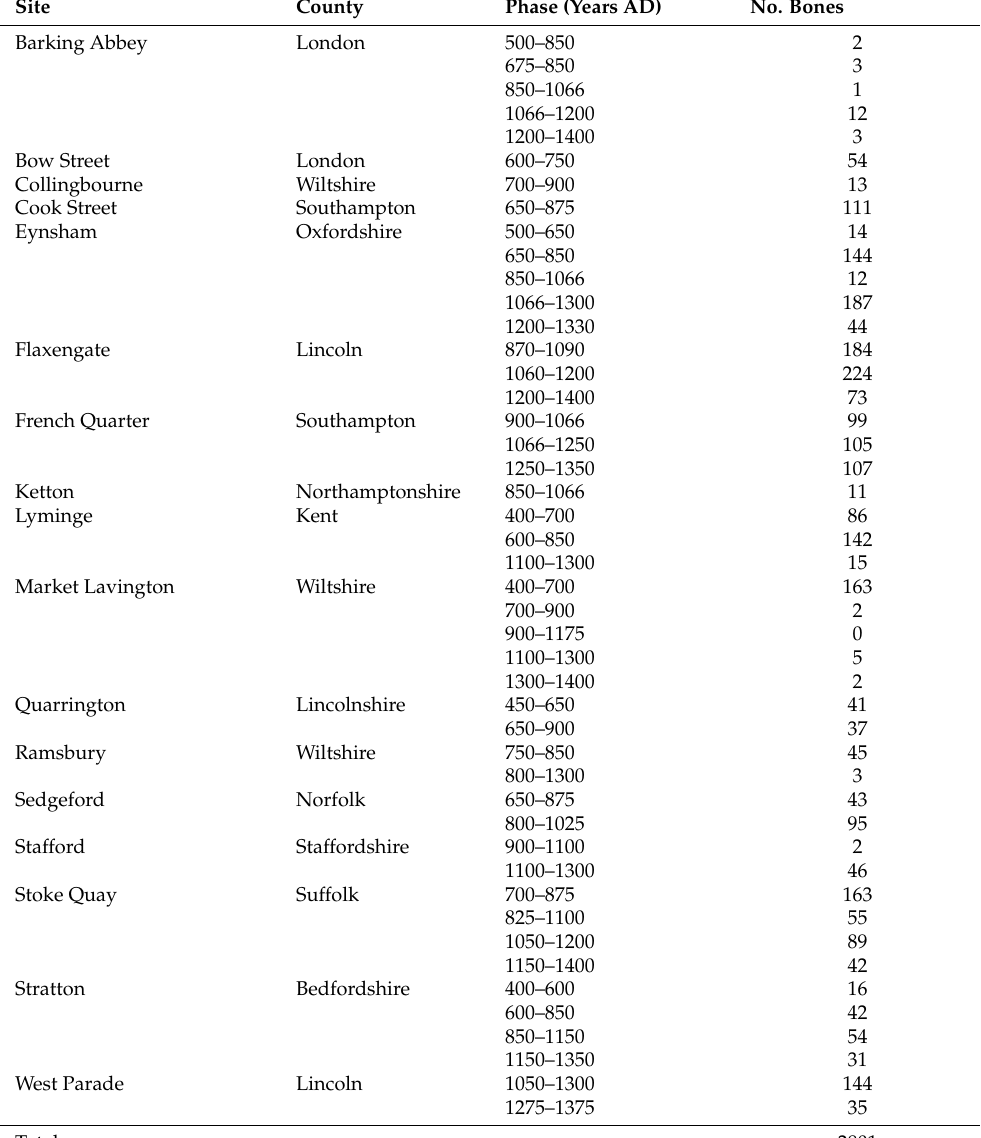
Table 2. Targeted sites showing the phases of occupation and the number of cattle foot bones (metapodials and phalanges)